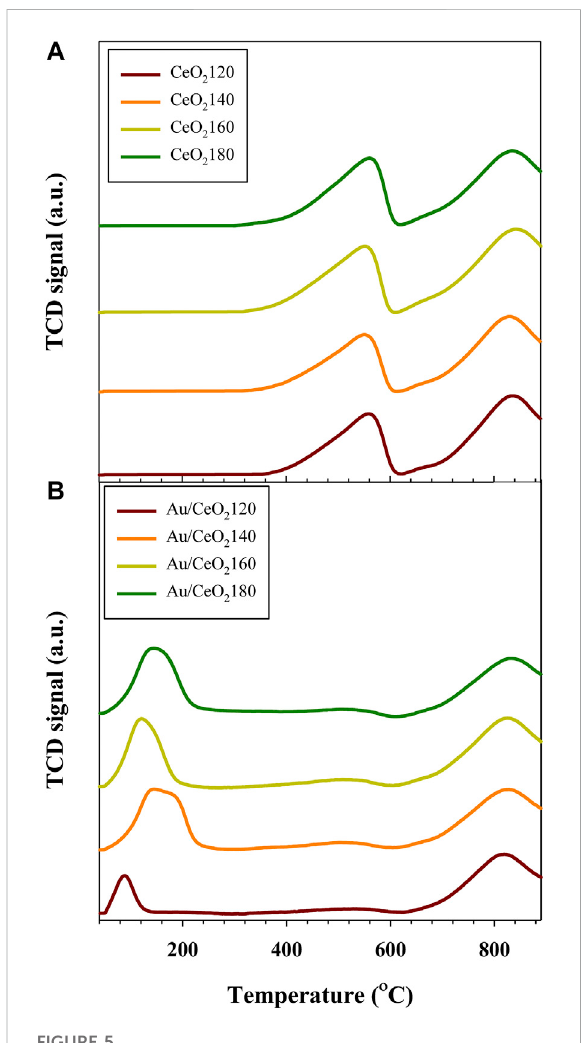
FIGURE 5 Representative H 2 -temperature-programmed reduction pro fi lesof (A) CeO 2 Xsupportsand (B) Au/CeO 2 Xcatalysts. CeO 2 X: cerium oxide obtained at a value X for the temperature of the preparatory hydrothermal process; Au/CeO 2 X: CeO 2 X-supported gold catalysts; TCD: thermal conductivity